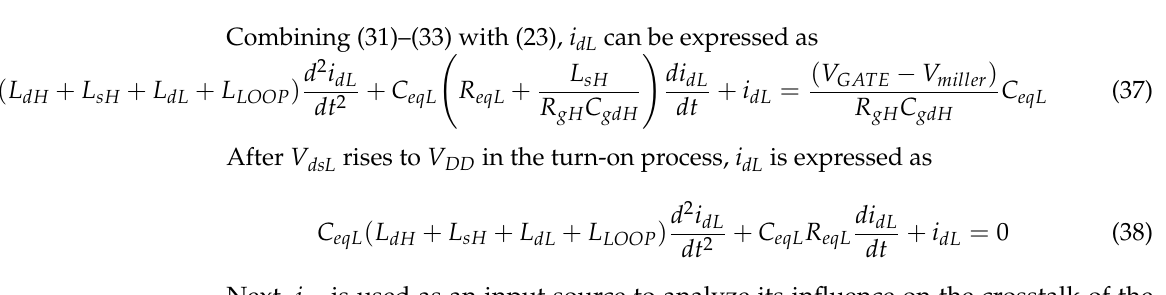
Figure 15. Relationships of i dL with the parameters of the bridge-arm.